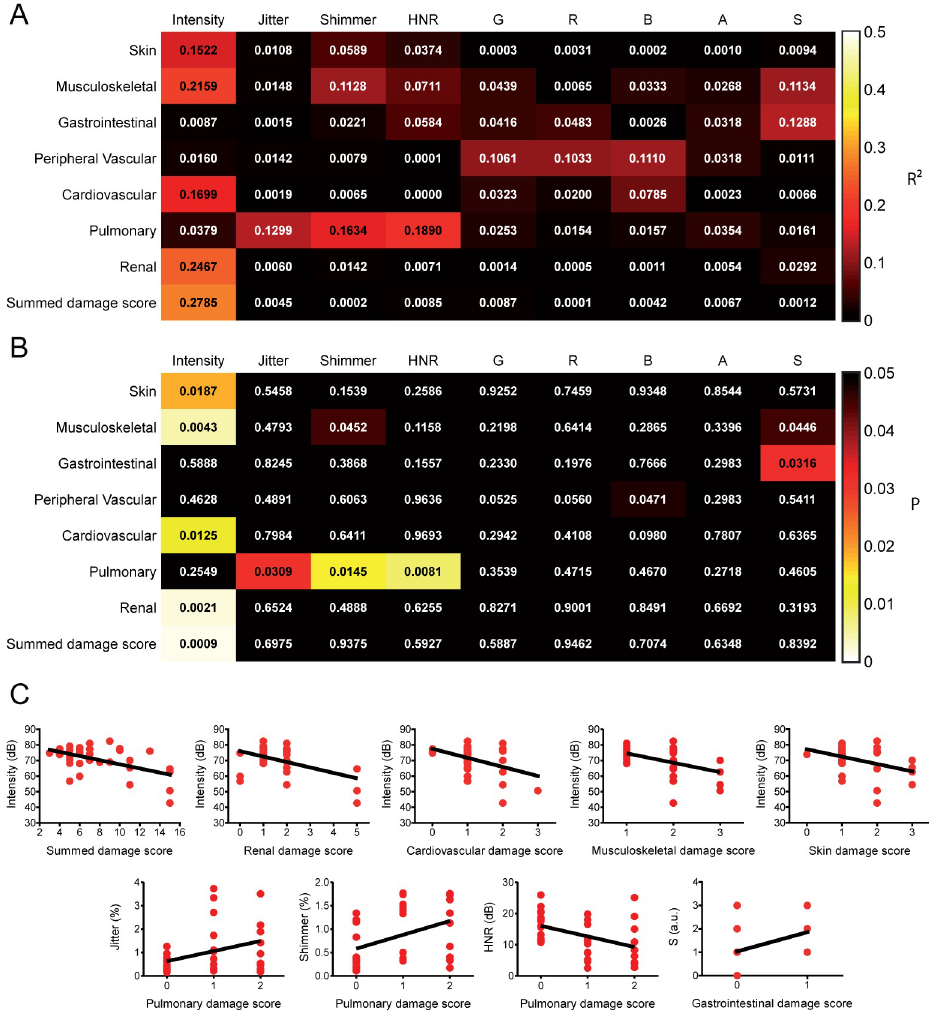
Fig 4. Linear regressions between objective and subjective vocal parameters with tissue damage as measuredby the SLICC/ACR damage index. A: Matrix representingthe R 2 values of linear regressions betweenselectedvariables. Note the high correlations(R 2 > 0.15) betweenintensity with summed damage scores and renal, cardiovascular, musculoskeletal and skin scores, as well as betweenpulmonarydamage scores with jitter, shimmer and HNR. B: Matrix representing the P values of linear regressions between selectedvariables. Note the significantcorrelations( P < 0.05) betweenintensity with summed damagescores and renal, cardiovascular, musculoskeletal and skin scores, as well as betweenpulmonarydamage scores with jitter, shimmer and HNR. C : Scatter-plot representations of selectedsignificantcorrelations identifiedin the correlation matrices in A and